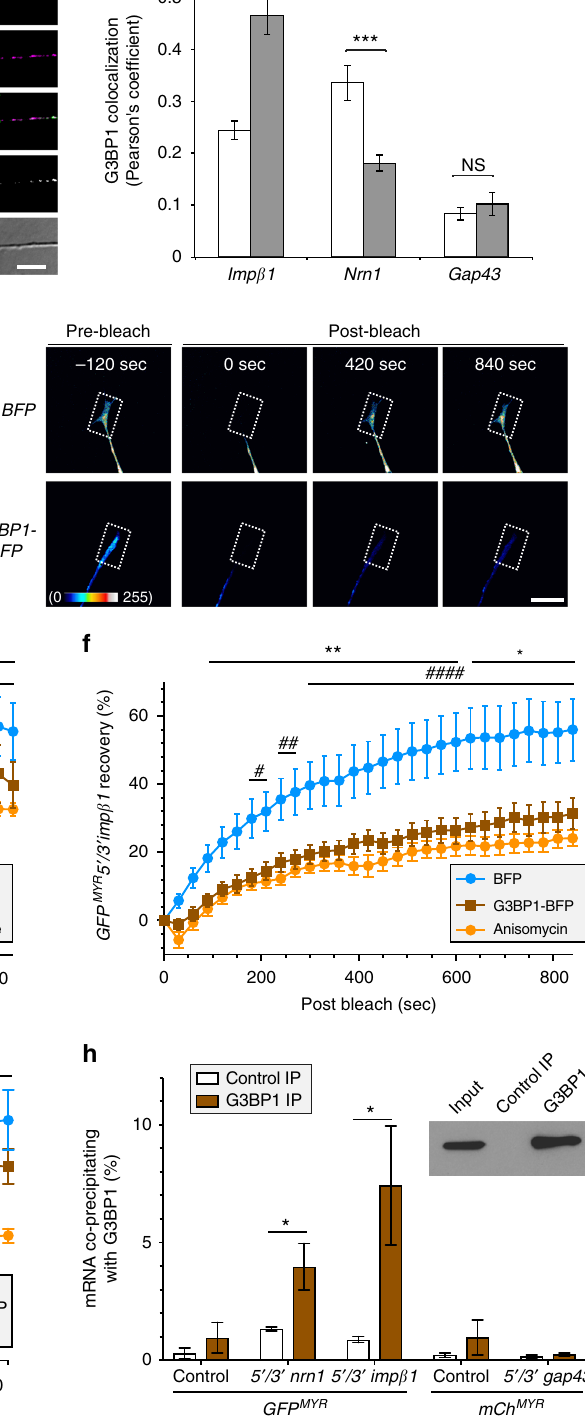
G3BP1-BFP expression (Fig. 3d – g, Supplementary Movies 1 – 3). Treatment with translation inhibitors con fi rmed that the fl uorescence recovery in axons after photobleaching represents new protein synthesis, and, interestingly, overexpression of